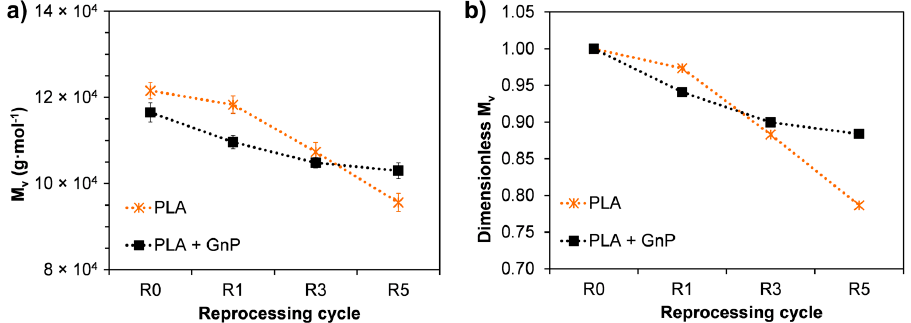
Figure 9. Viscous molar mass ( M v ) as a function of reprocessing cycles ( a ) and dimensionless M v as a function of reprocessing cycles ( b ) for PLA and PLA + GnP systems. Dimensionless values have been calculated as ratio between M v values of reprocessed materials and the M v value of the corresponding R0 material.